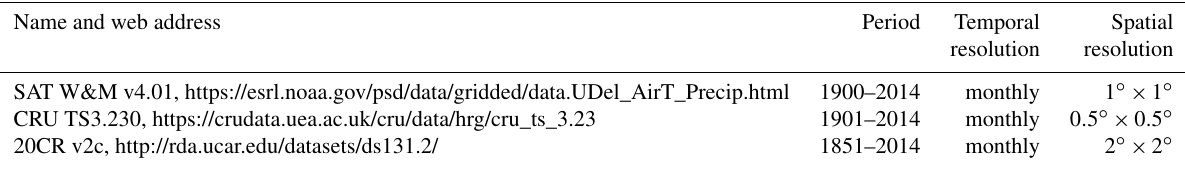
Table 2. Three gridded SAT datasets that are used in this study. Name and web address Period Temporal Spatial